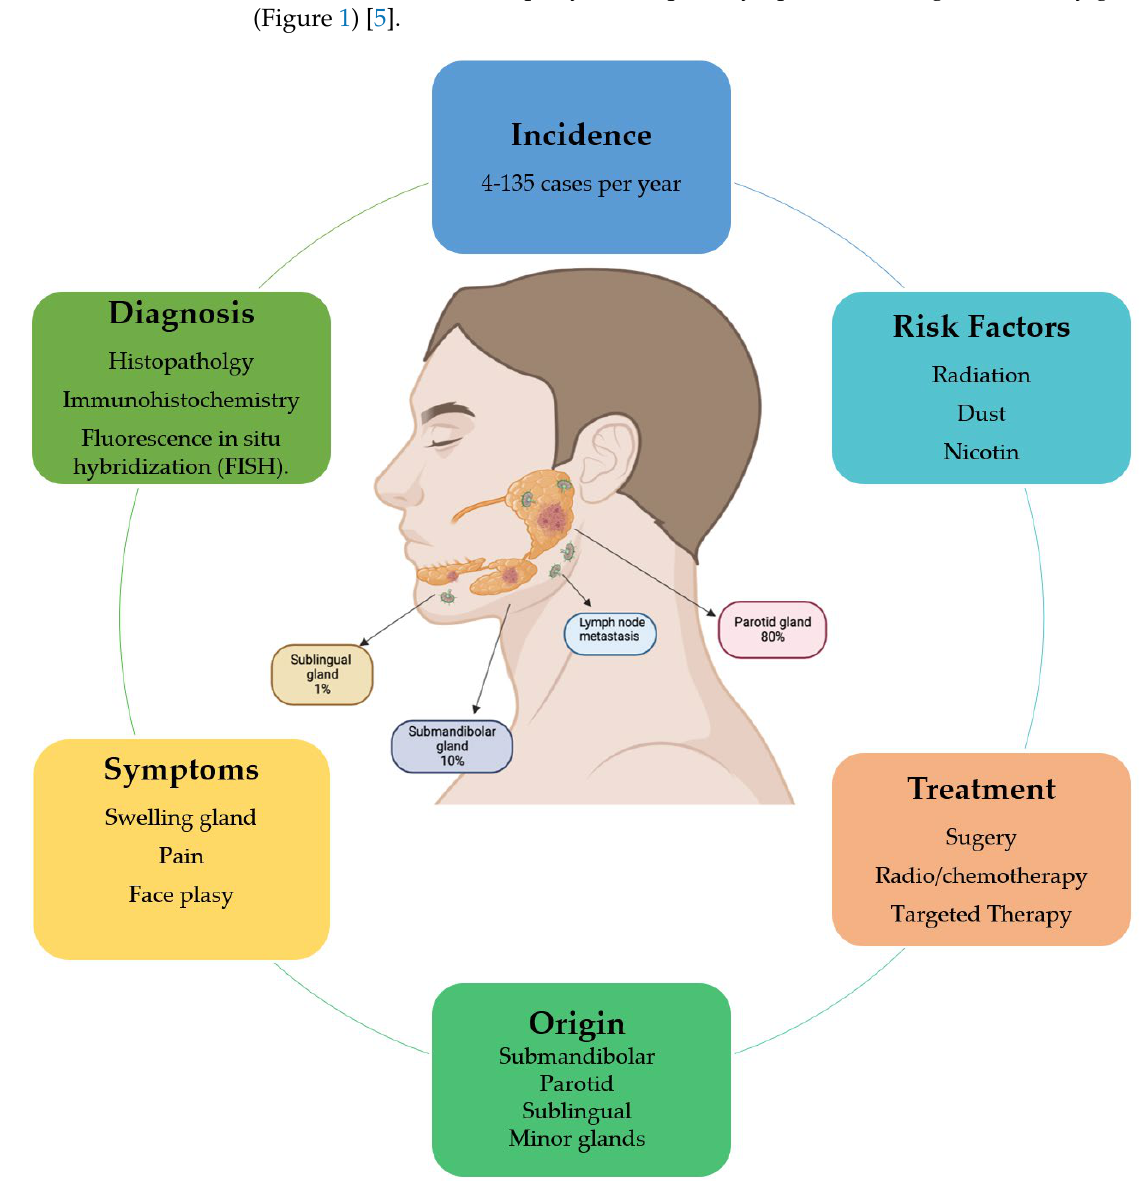
Figure 1. Schematic representation of salivary gland cancer features and prevalence in the major glands.